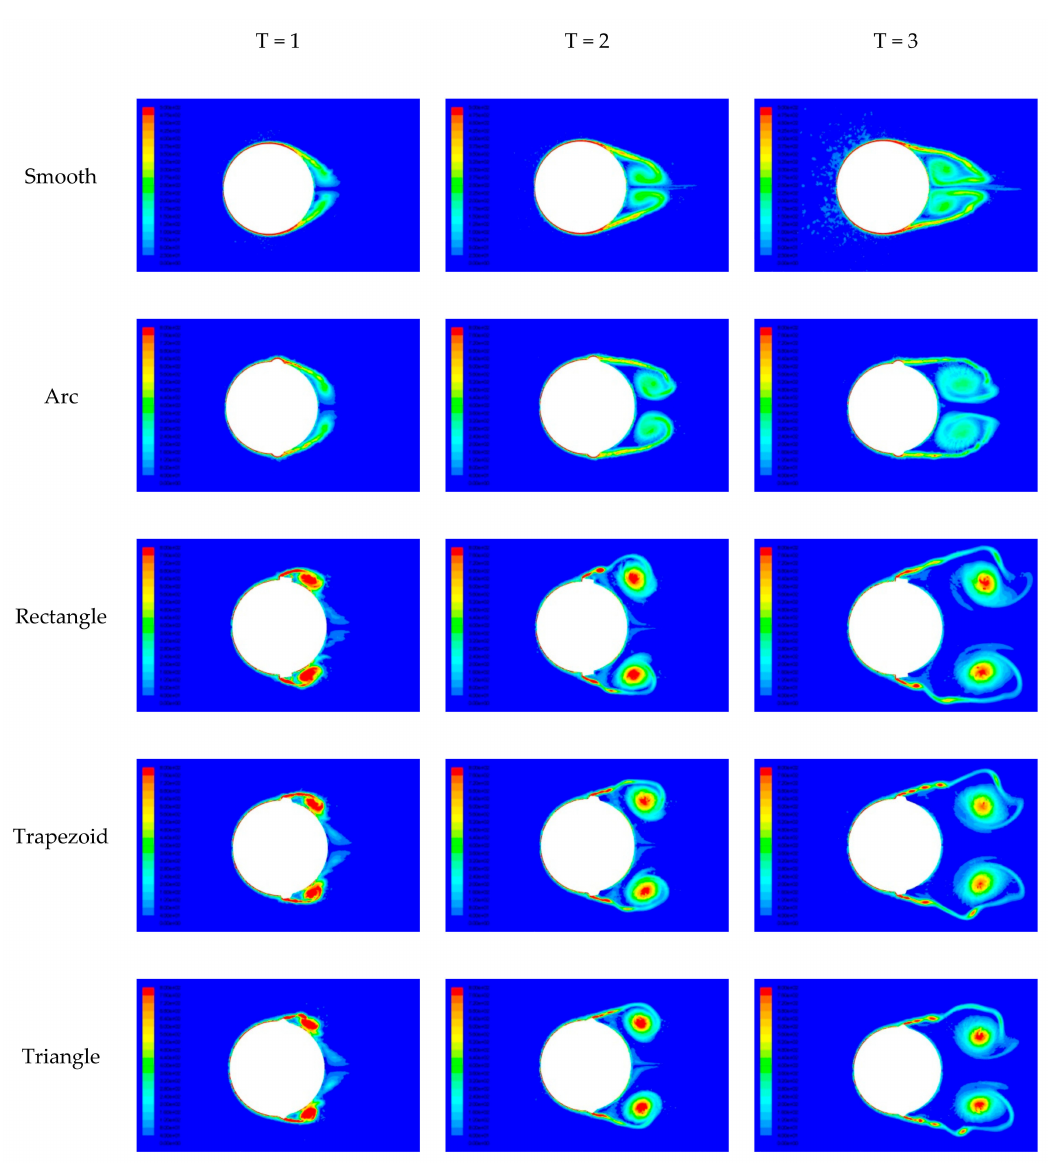
Figure 14. The vorticity contours of the wake flow for di ff erent shapes of strips for Re = 55,000. Figure 15 compares the pressure coe ffi cient between the smooth cylinder and cylinder with ◦ strips of di ff erent shapes attached at α = 90 . Only the pressure of the upper-half cylinder is shown, because of the symmetrical distribution. Due to the installation of the strips, the pressure coe ffi cient ◦ fluctuates significantly at θ = 90 . The di ff erence is that a valley is created at the arc strips, while the peaks are created at the rectangular strips, the trapezoidal strips and the triangular strips. When T = 1, the pressure coe ffi cient curve of the rectangular strips, the trapezoidal strips and the triangular strips ◦ ◦ have a valley at θ = 125 and gradually moves to θ = 150 , as time goes on. When T = 3, the valleys disappeared, indicating that the e ff ect of the strips gradually diminishes with